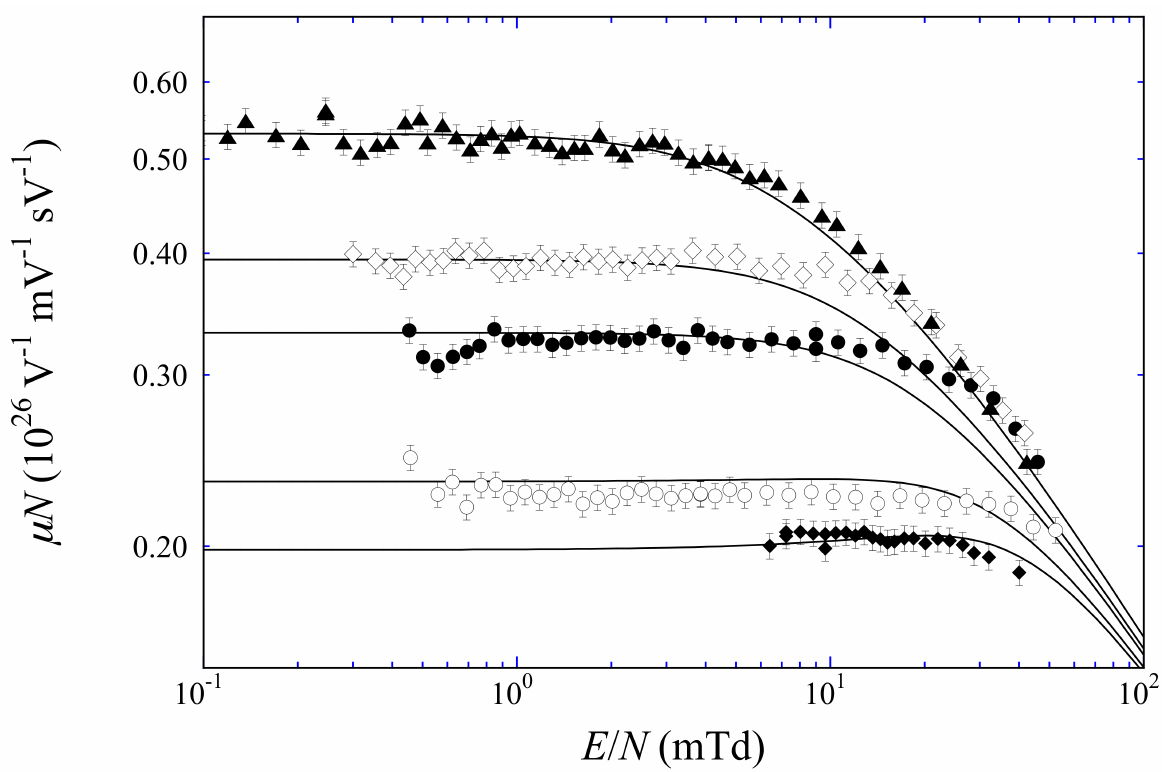
Figure 6. µ N vs. E / N for T = 64.4 K. Densities (from top, in units of 10 26 m − 3 ): N = 2.79, 12.95, 18.20, 27.54, 31.38. The solid lines are the predictions of the heuristic model.